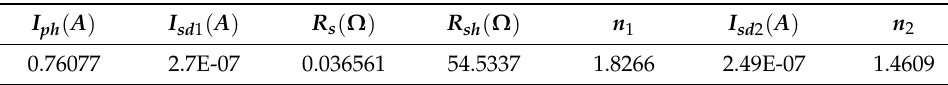
Table 2. Depiction of an initial solution for